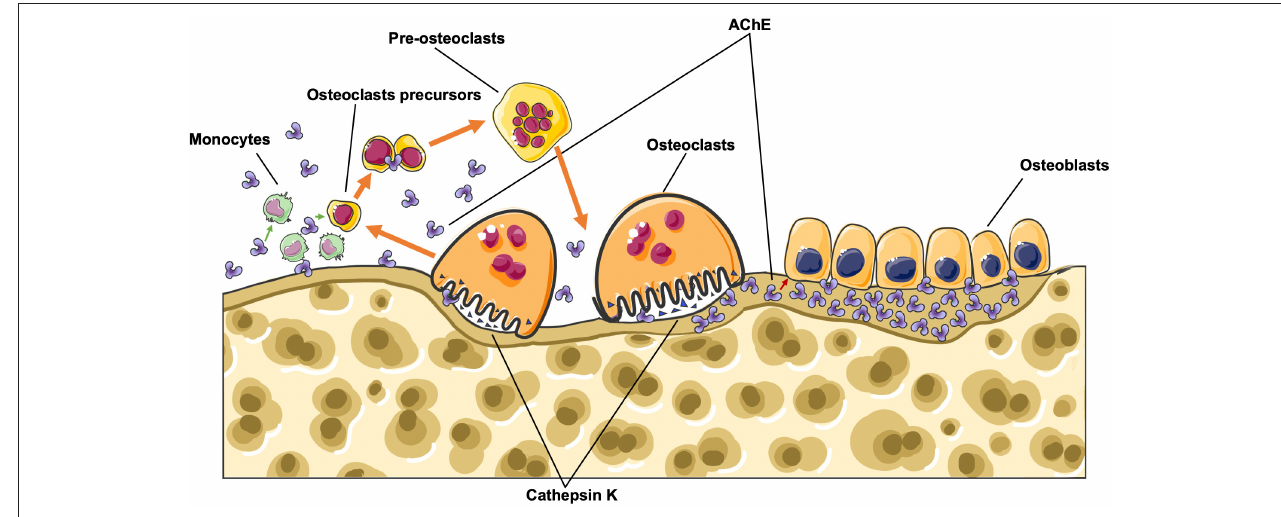
FIGURE 2 | During bone remodeling, AChE is secreted by osteoblasts as adherent protein and is trapped in bone matrix during bone mineralization, when osteoclasts digest the bone matrix, AChE will be released to the surroundings, and therefore promote